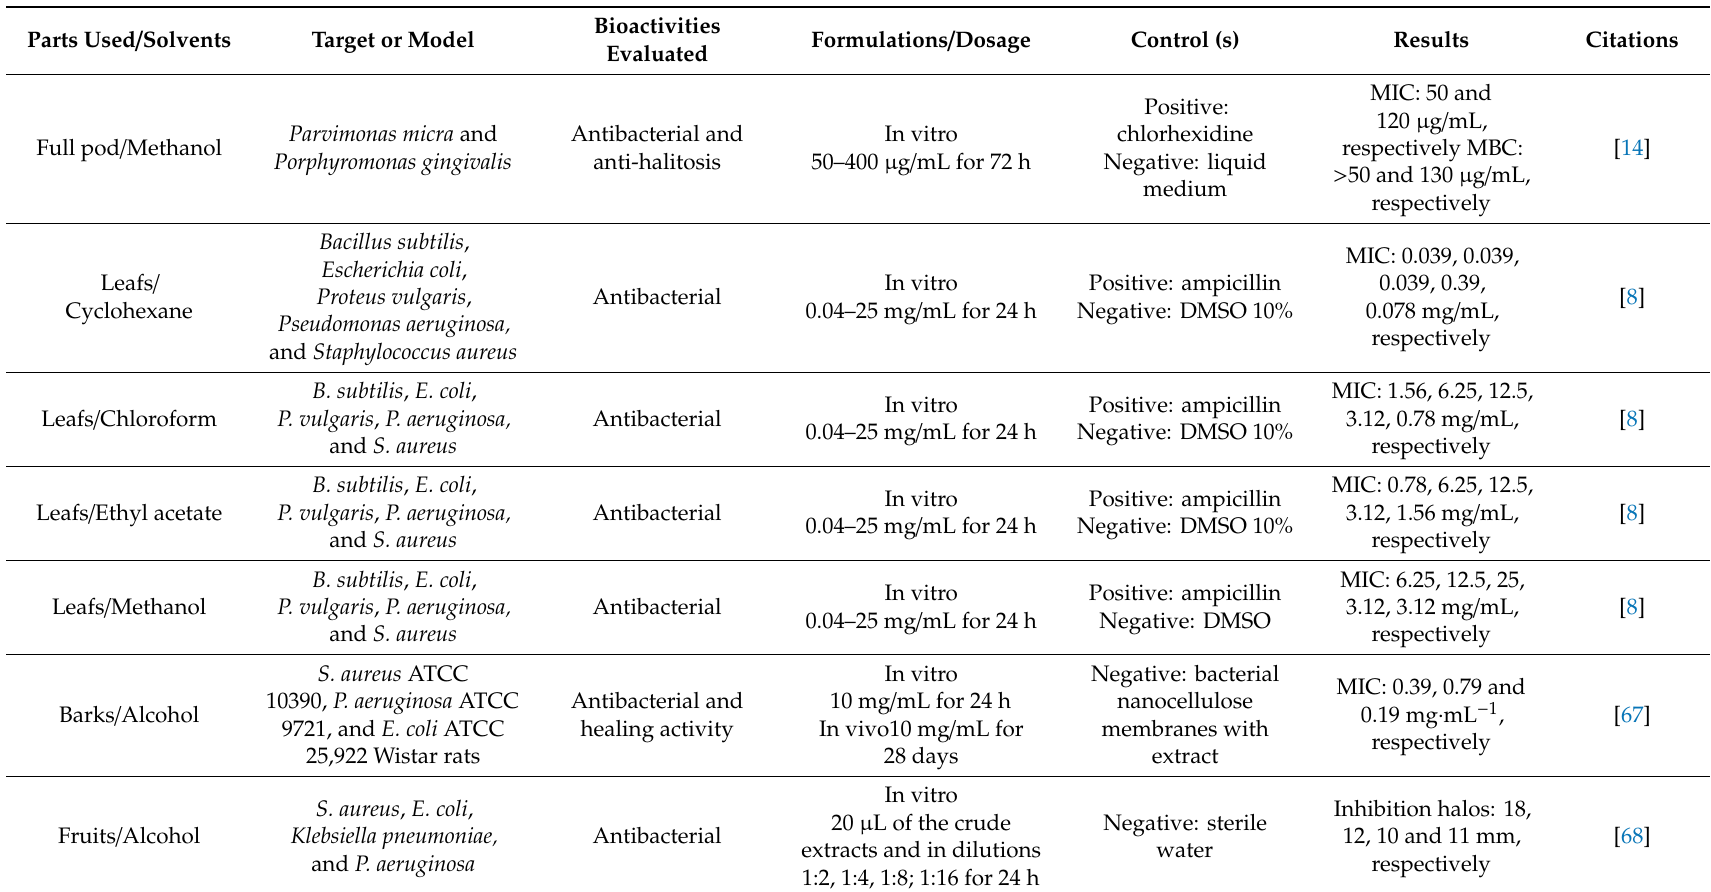
Table 4. Bioactivities evaluated with di ff erent extracts of C. ferrea